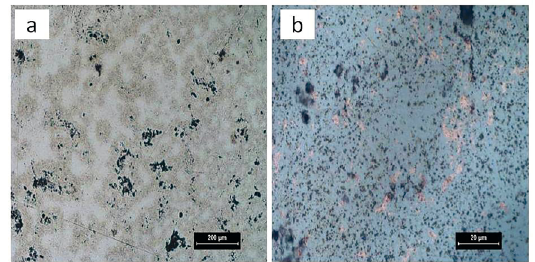
Figure 8. (a) Optical micrograph of W-30 wt% Cu composite at different magnifications.